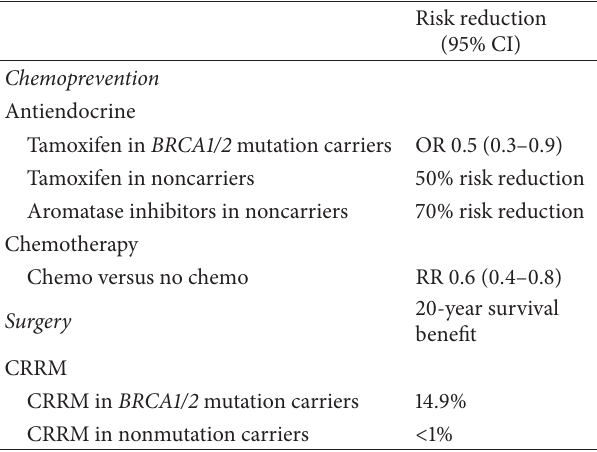
Table 2: Risk reduction of CBC associated with chemoprevention and